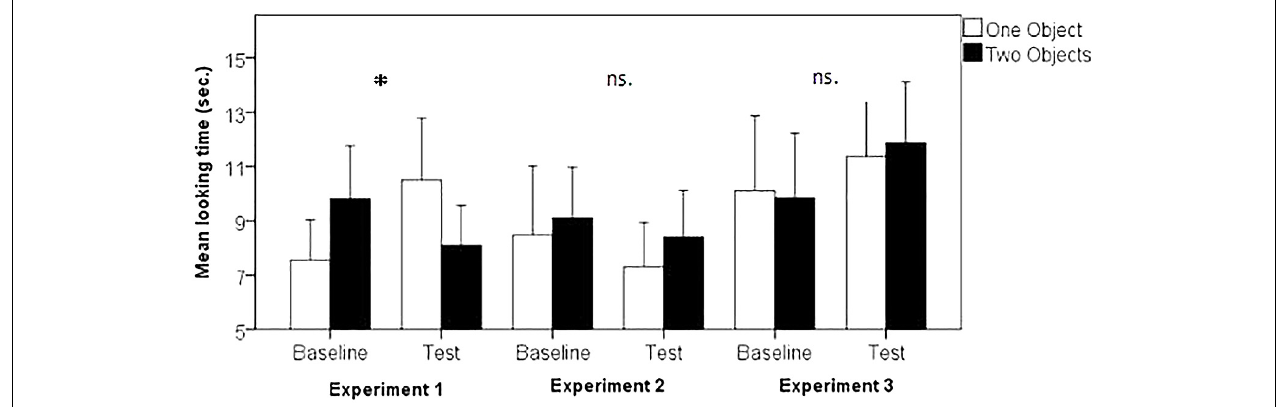
FIGURE 2 | Looking times in Experiments 1–3, contrasting one vs. two objects as outcomes. Error bars represent standard error of the mean. Asterisks mark statistical significant differences ( p <